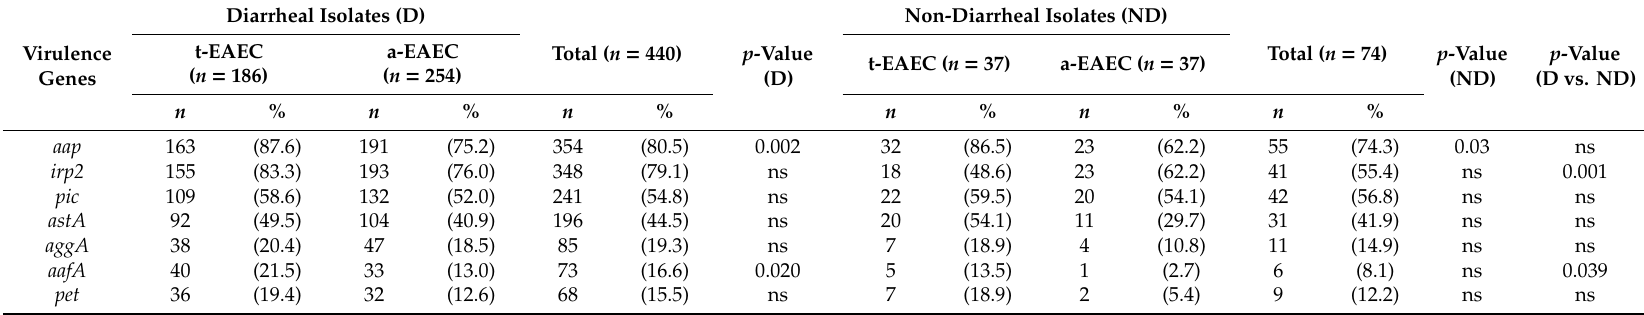
Table 3. Prevalence of virulence genes of EAEC isolated from diarrheal and non-diarrheal cases among Bolivian children. ns = nonsignificant.